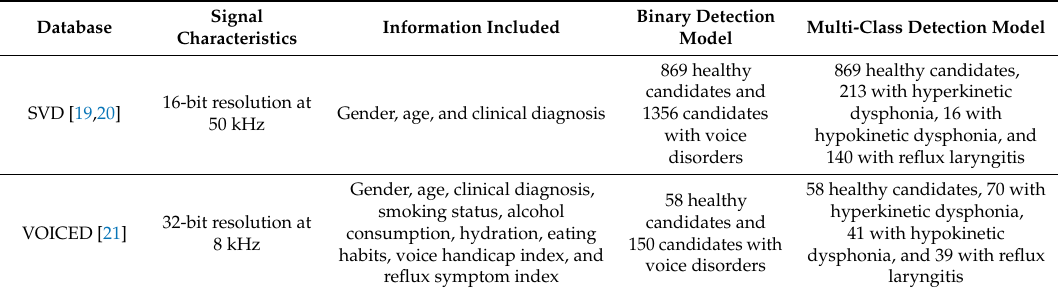
Table 1. Key information on the databases Saarbruecken Voice Database (SVD) and Voice ICar fEDerico II Database